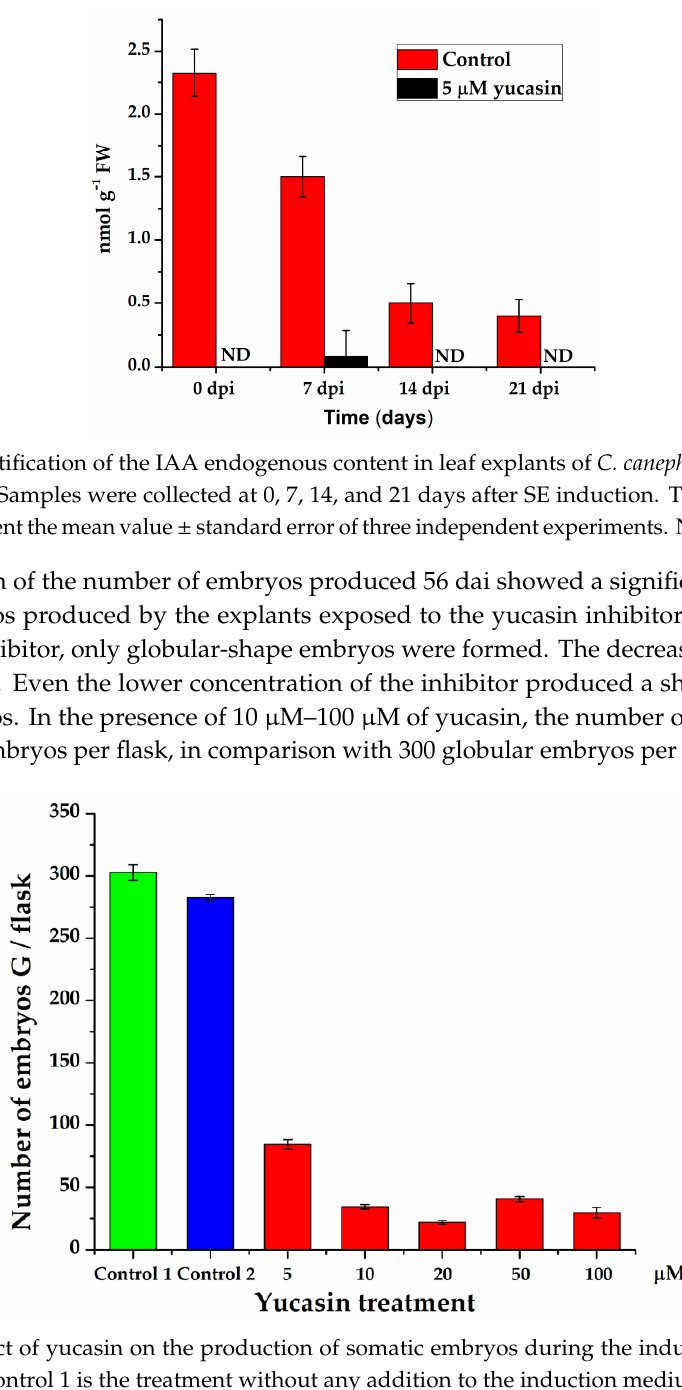
Figure 10. Effect of yucasin on the production of somatic embryos during the induction process in C. canephora . Control 1 is the treatment without any addition to the induction medium. In Control 2, DMSO was added to the semisolid pre-treatment medium. Only globular-stage embryos were formed after 56 days, so the comparison was limited to the number of globular embryos formed throughout SE induction. The data are the results of three independent biological experiments; the bars represent the standard error.